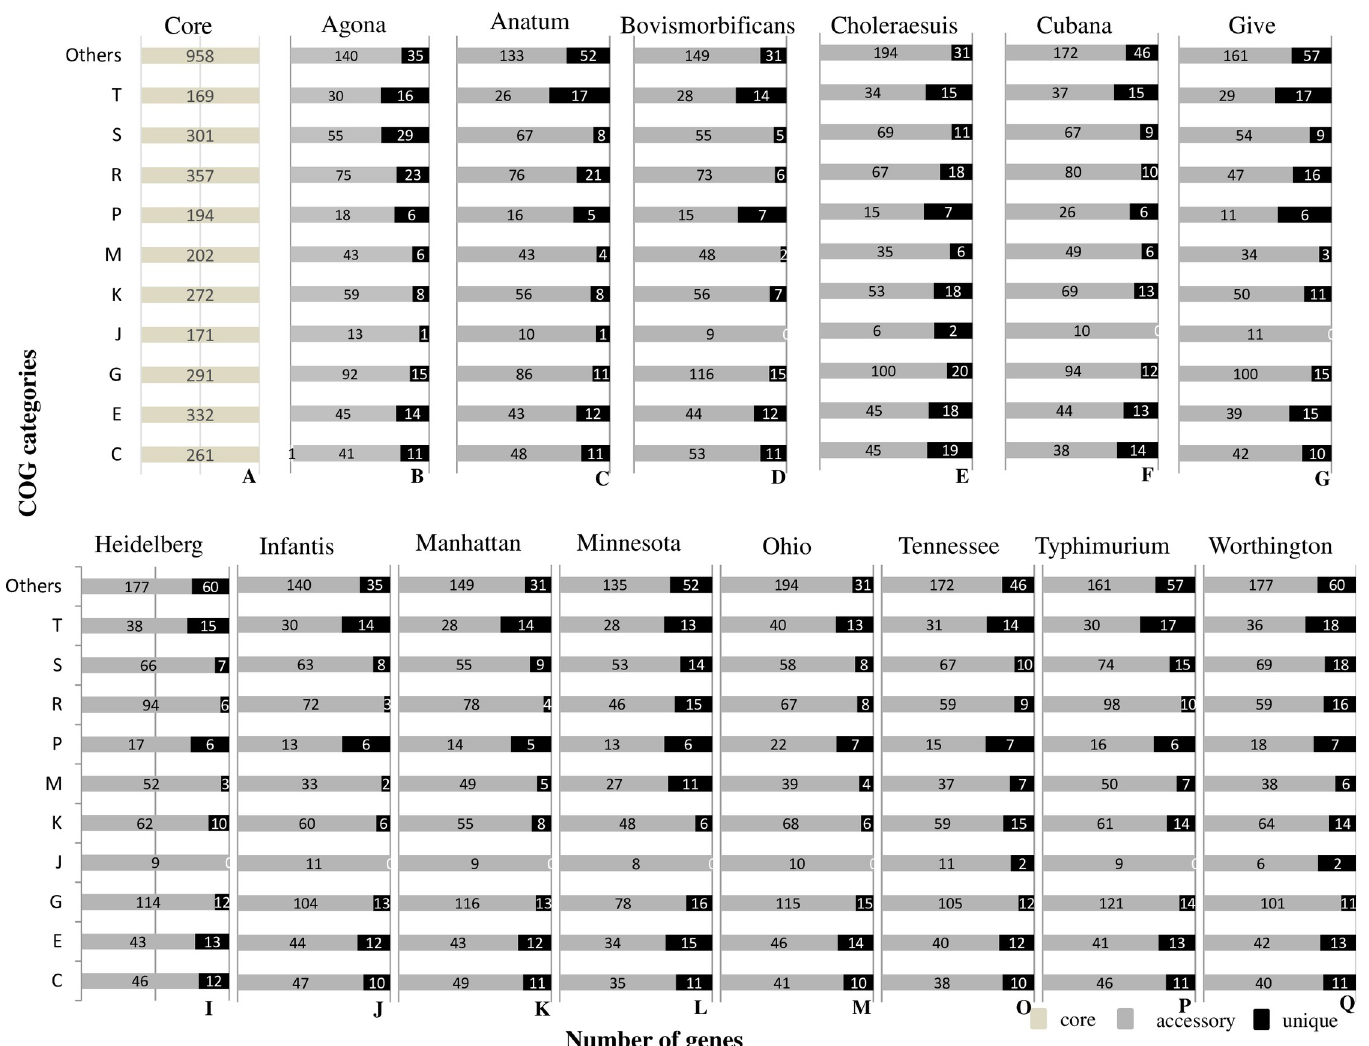
Fig 4. Distribution of clusters of orthologous groups in core, accessory and unique genes in the genomes of different Salmonella serovars. Common numbers of core genes in each COG categories were observed and presented in Fig 4(A), The bars represents the number of clusters of orthologous groups assigned genes present in accessory (grey bars) and in the unique genes (black